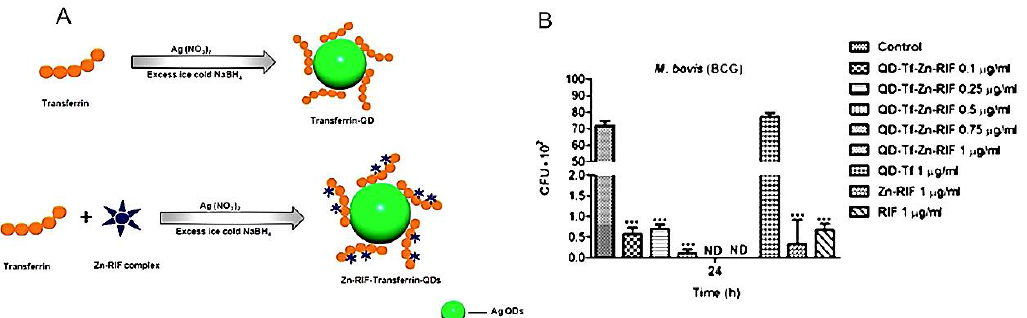
Figure 3. Antimicrobial effect of transferrin-modified silver QDs coupled with zinc and rifampicin (Zn/RIF/Tf QDs). ( A ) Schematic illustration of transferrin-embedded Zn/RIF complex silver QDs. ( B ) Antibacterial activity of Zn/Rif/Tf QDs. Dose-dependent killing of Mycobacterium bovis BCG using Zn/RIF, Tf QDs, RIF, and Zn/RIF/Tf QDs after 24 h. The bacteria were incubated with different concentrations of Zn-RIF, Tf QDs, RIF, and Zn/RIF/Tf QDs, and their survival rate was determined at the indicated time points. Media containing bacteria alone were used as control, and the corresponding concentrations of RIF and Zn(NO 3 ) 2 present in respective doses of the Zn/RIF complex were used as rifampicin and Zn(NO 3 ) controls, respectively. The images were reproduced with permission from Reference [19], Nature 2016.